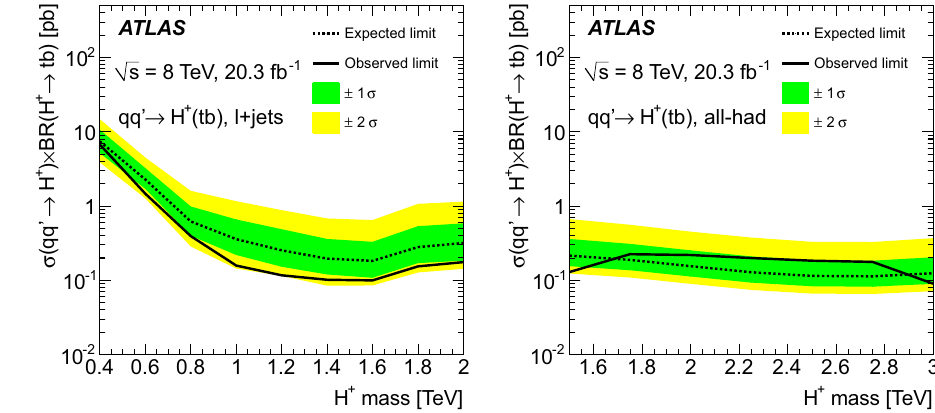
tion of H + → t ¯ b in association with a top quark. The red dash-dotted line shows the expected limit obtained for a simulated signal injected at M H ± = 300 GeV. (Reprinted with kind permission from JHEP and the authors, Fig. 6 of [219])